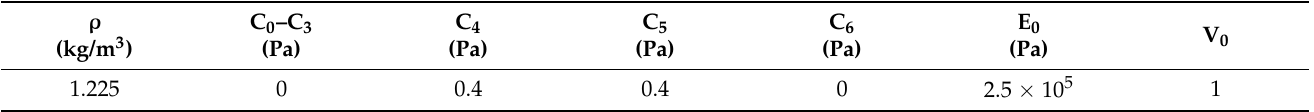
Table 3. MAT_HIGH_EXPLOSIVE_BURN material model and EOS_JWL parameters of the JH-2